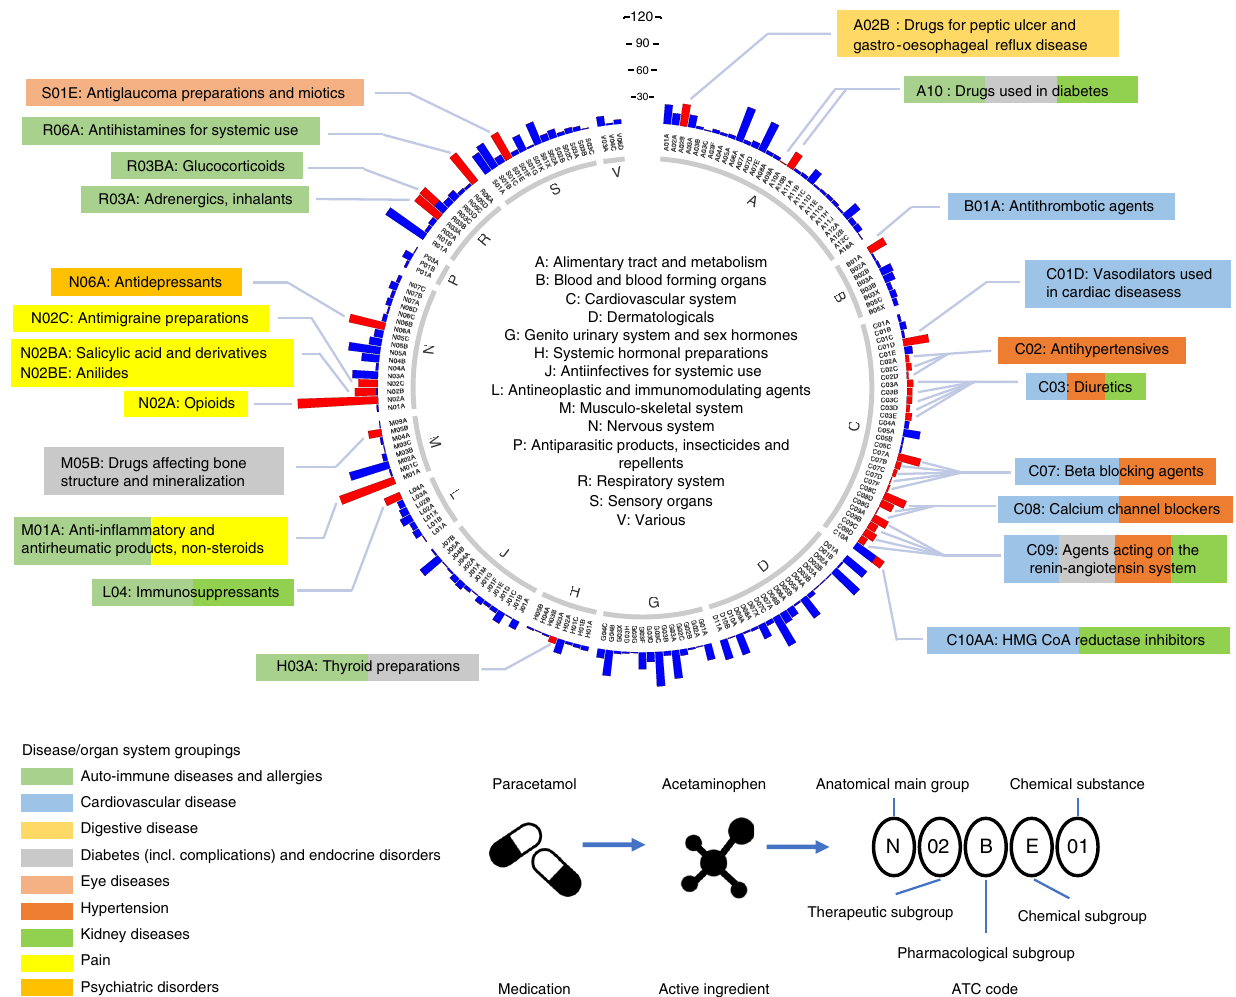
Fig. 1 Distribution of 1,752 UKB medications at the fi rst three ATC level. The inner ring corresponds to the fi rst level of the ATC code. The outer ring represents the fi rst three levels of the ATC code (184 subgroups). The length of the bar represents the number of classi fi ed UKB medications assigned to that subgroup. Red bars are the 23 medication-taking traits used in analyses (selected based on participant numbers, as shown in Fig. 2). The 23 medication-taking traits are grouped into nine diseases and organ system categories according to the main indications, which is highlighted using different colours (legend at the bottom left). The legend at the bottom right shows how ATC codes are assigned to each UKB